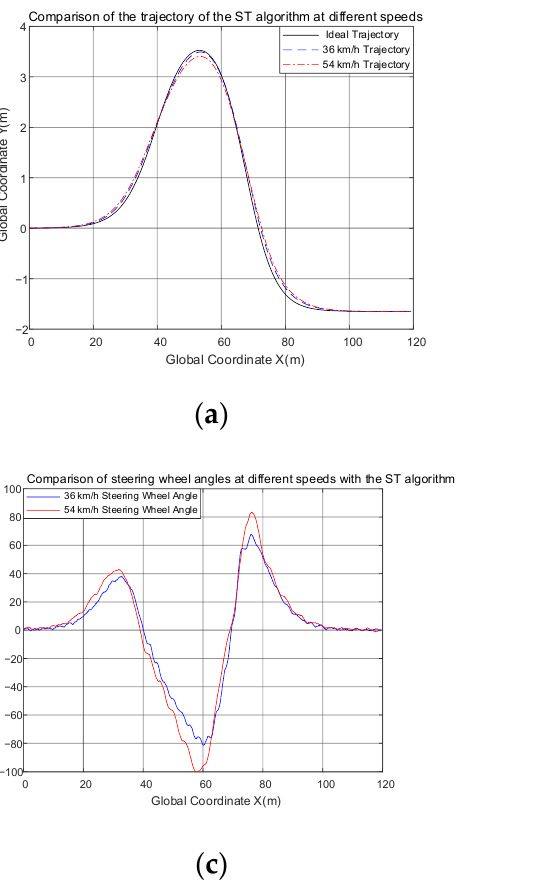
Comparison of steering wheel angles at different speeds with the ST algorithm 36 km/h Steering Wheel Angle